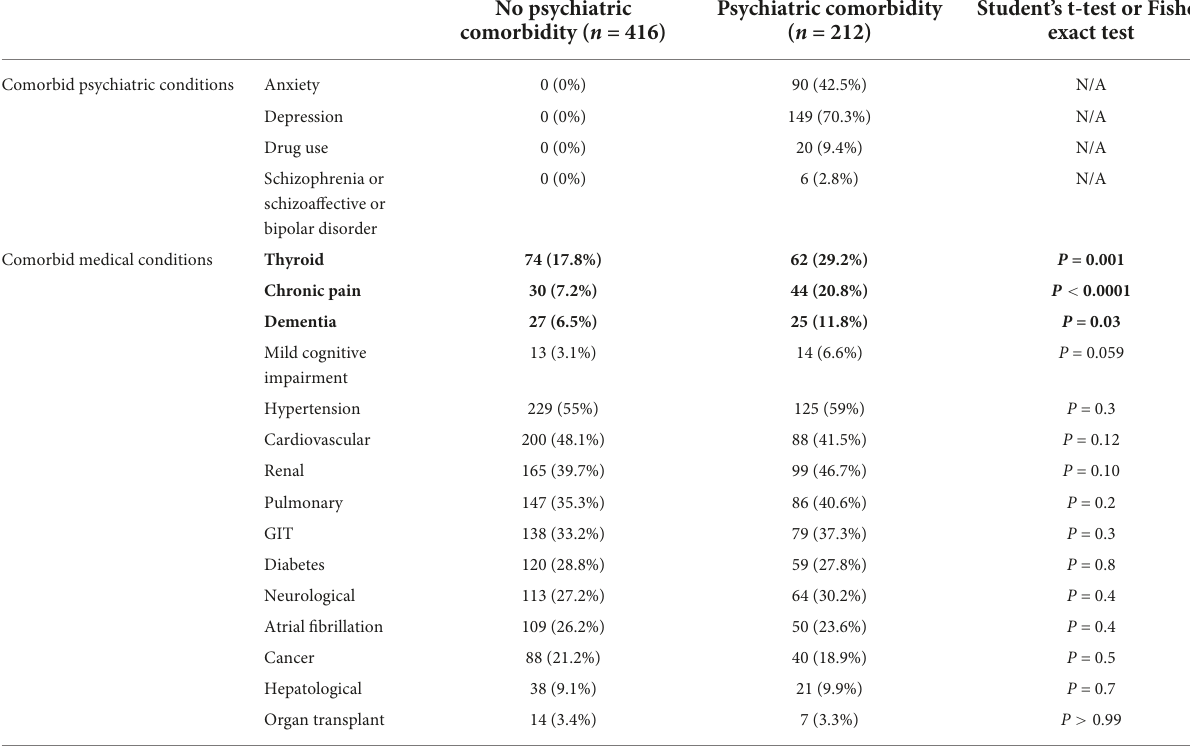
TABLE 2 Psychiatric and medical comorbidities.